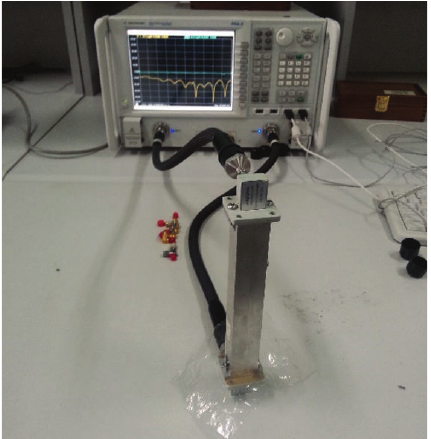
Figure 6: Accumulation of polyhedrons.